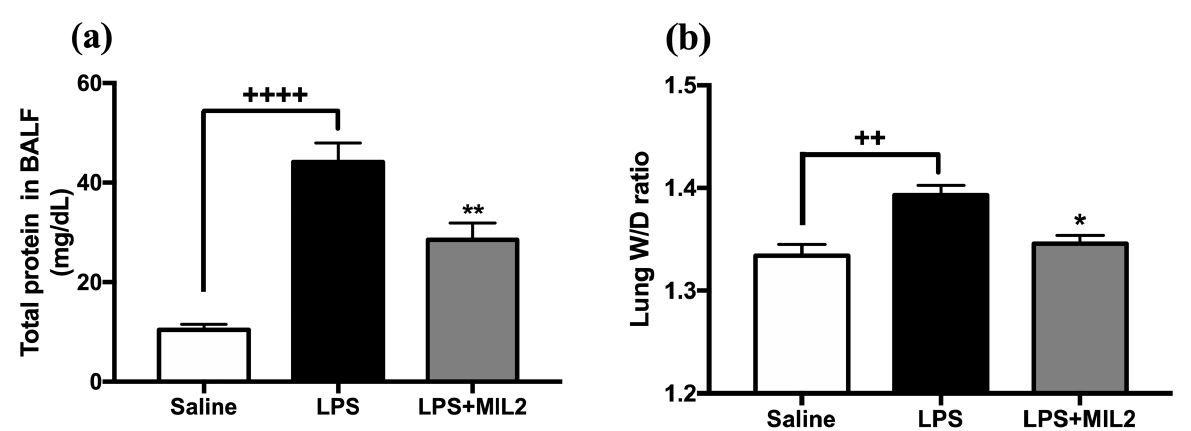
Figure 3. Effect of milonine on the microvascular protein permeability and pulmonary edema. BALB/C mice (n = 6) were LPS-challenged and treated with milonine (2.0 mg/kg; LPS+MIL2; p.o) or vehicle (LPS group). The saline group was saline-challenged. The bronchoalveolar lavage fluid (BALF) was recovered 24h after the challenge and evaluated: the total protein concentration (a) and the lung w/d ratio (b). The results represent the mean ± SEM and submitted to the one-way ANOVA analysis of variance, followed by the Turkey post-test ++ p <0.01, ++++ p <0.0001 comparison between LPS and saline group; * p <0.05 and ** p <0.01 for comparison of the group treated with milonine and the LPS